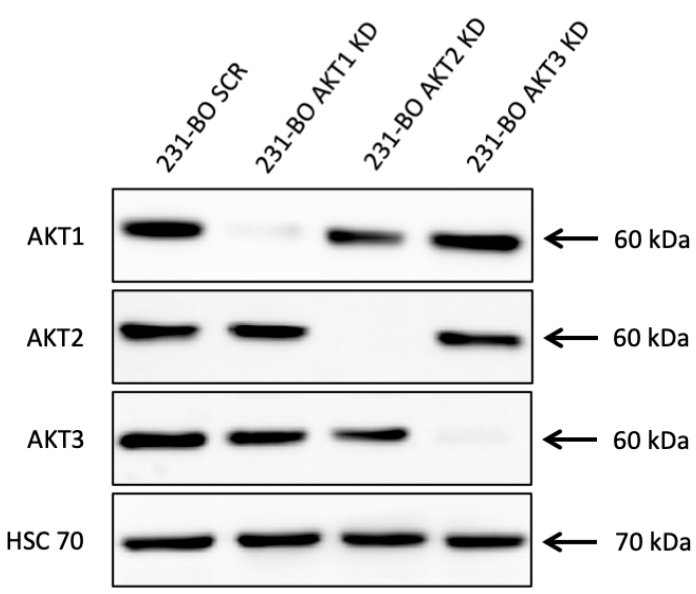
Figure 4. Lentiviral shRNA knockdown of AKT isoforms in 231-BO cells: Knockdowns of AKT isoforms were generated using lentiviral transduction of isoform-specific shRNA. Knockdown was confirmed by Western blot analysis and AKT1, AKT2, and AKT3 were detected with isoform-specific antibodies. HSC70 functions as a loading